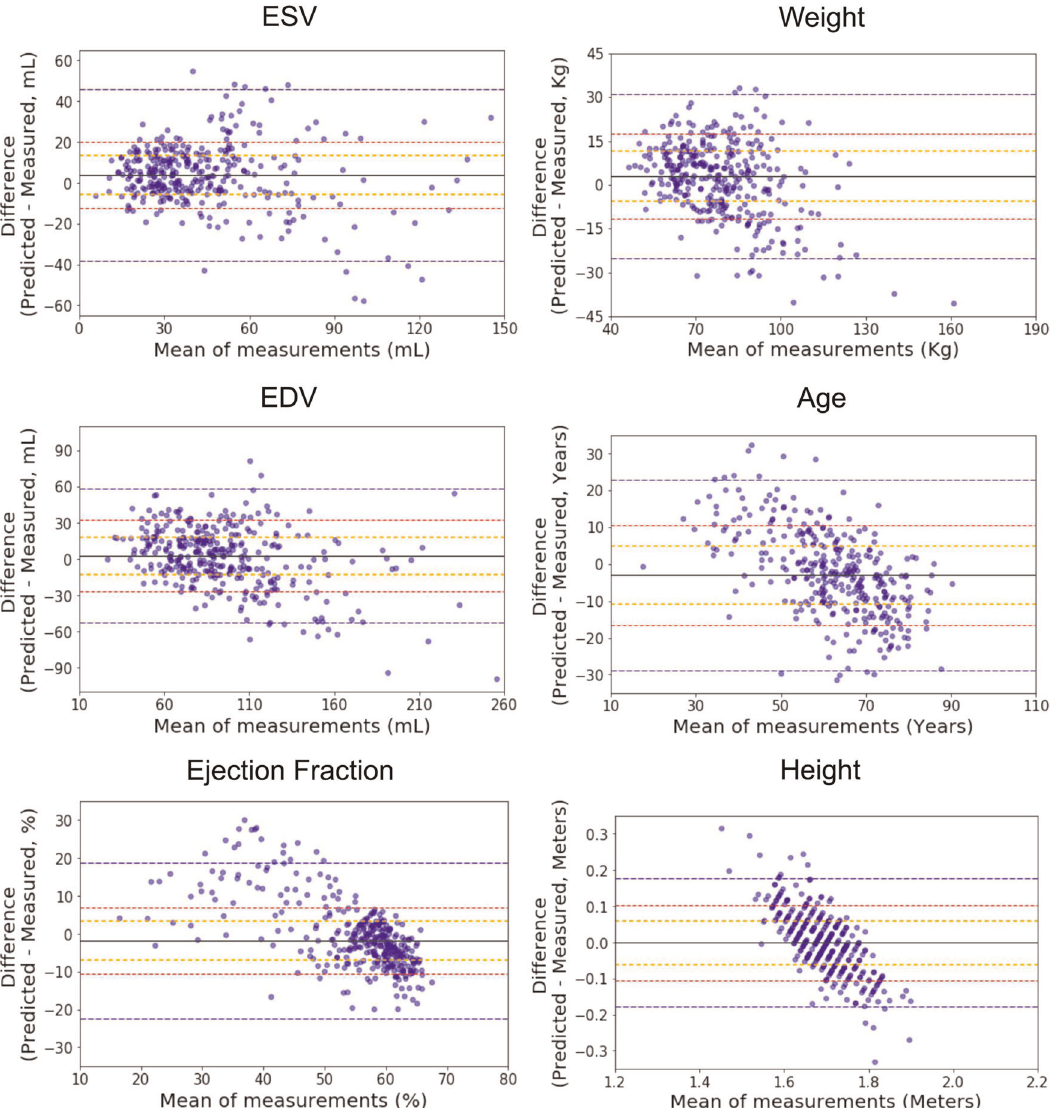
Fig. 5 Bland-Altman plotsBland-Altman plots of EchoNet performance for regression predictiontasks. The solid black line indicates the median. Orange, red, and blue dashed lines delineate the central 50%, 75%, and 95% of cases based on differences between automated and measured